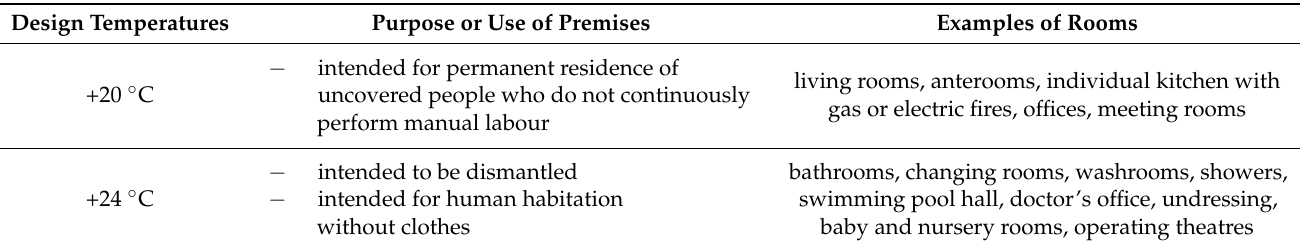
Table 1. Values of internal